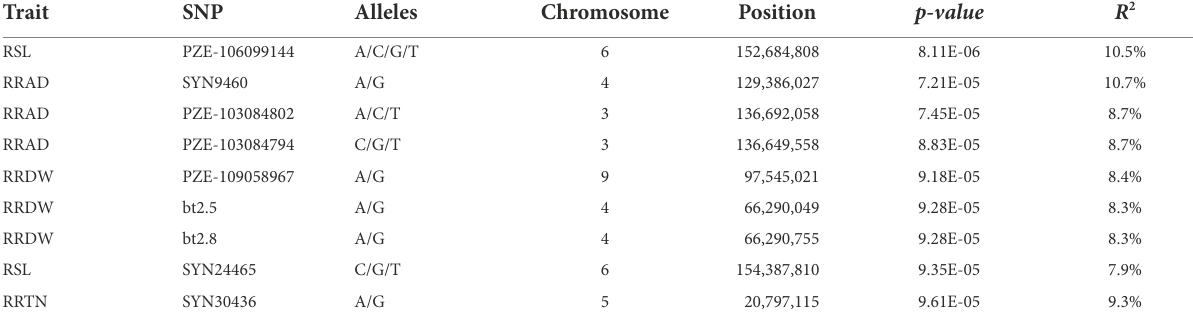
TABLE 2 SNPs associated with alkaline tolerance detected in 200 maize inbred lines.